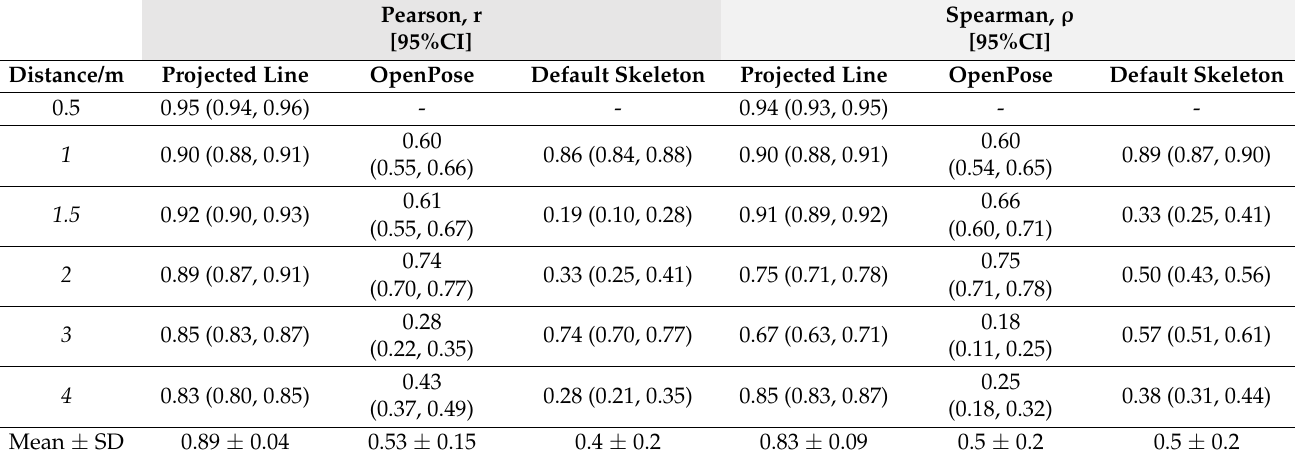
Table 2. In distance tests, correlation coefficients obtained by the projection lines method based on RCNN Mask proposed in this work, OpenPose software and the Kinect default skeleton, versus the IMUs gold standard. All Pearson’s and Spearman’s p -values < 0.0001.